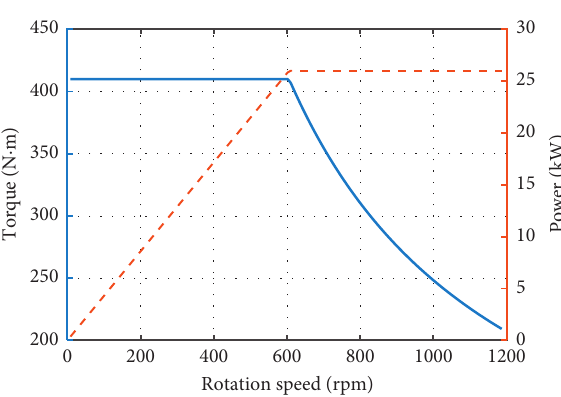
Figure 2: Motor external characteristic